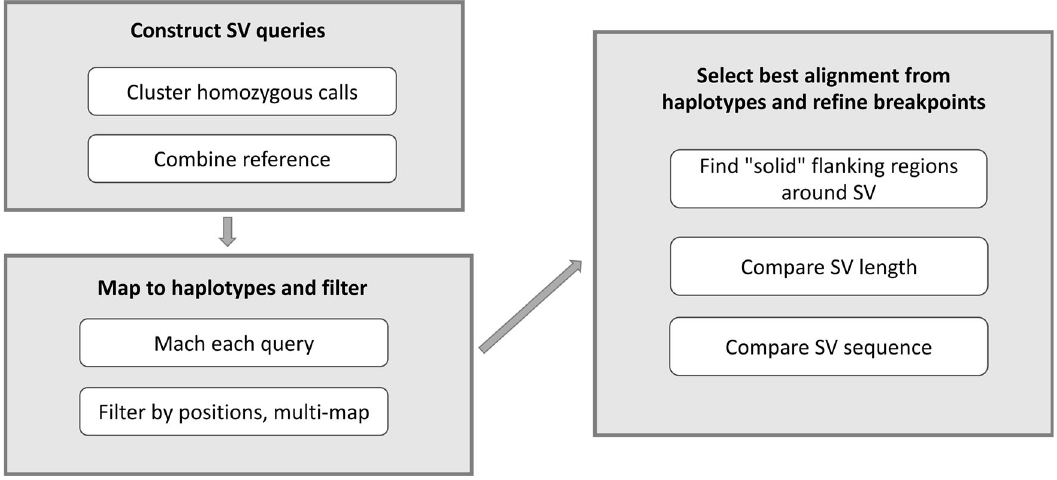
Figure 10. Implementation pipeline of XSVLen software package. A graphical representation of the XSVLen software pipelineshowingthe utilisationofhaplotype-resolved de novoassembly andaVCFfile tobenchmarking SV detection